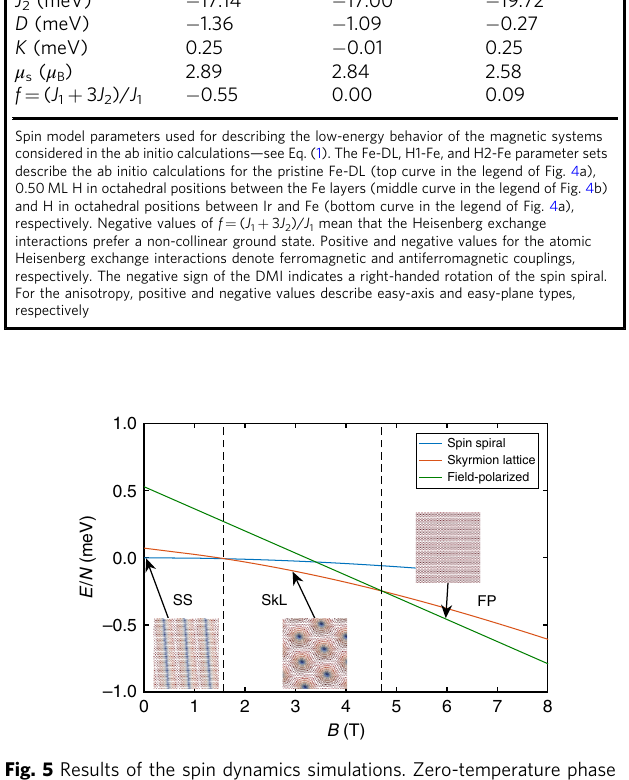
Fig. 5 Results of the spin dynamics simulations. Zero-temperature phase diagram of the model describing the H1-Fe system with the parameters from Table 1, displaying the energy per spin in different magnetic structures as a function of the strength of the external fi eld B applied perpendicular to the surface. Dashed black lines indicate the transition fi elds between the spin spiral, skyrmion lattice, and fi eld-polarized states. Insets display the ground states observed at selected fi eld